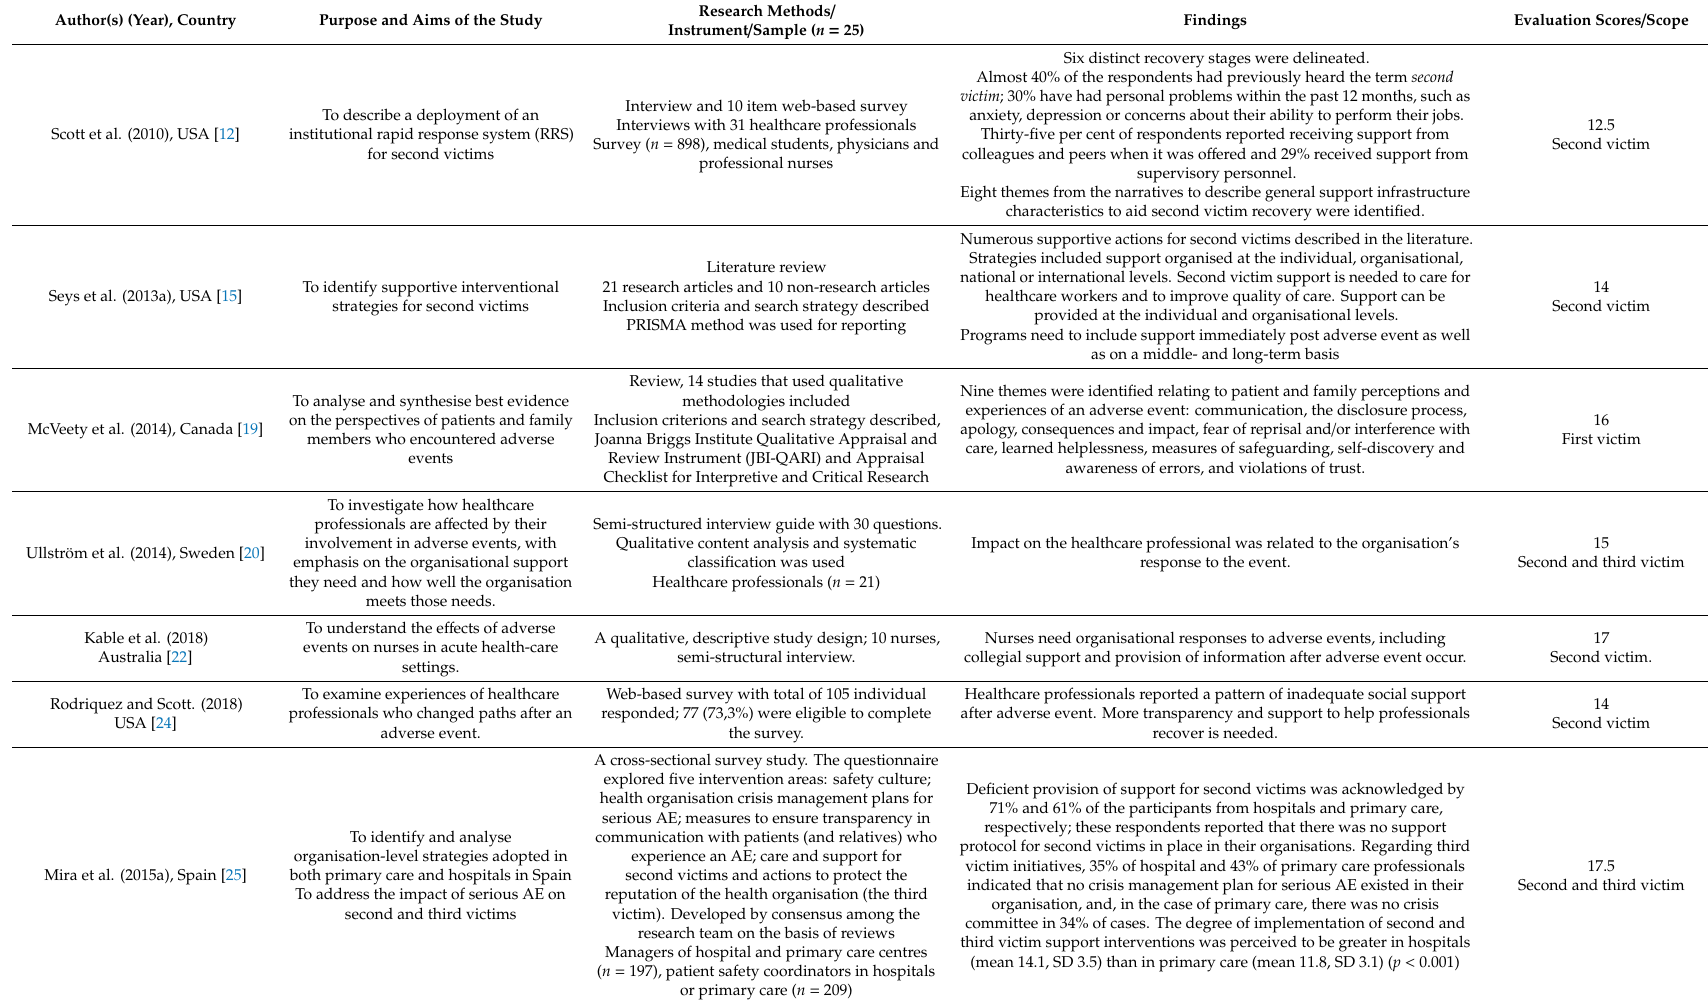
Table 1. Studies investigating action after adverse